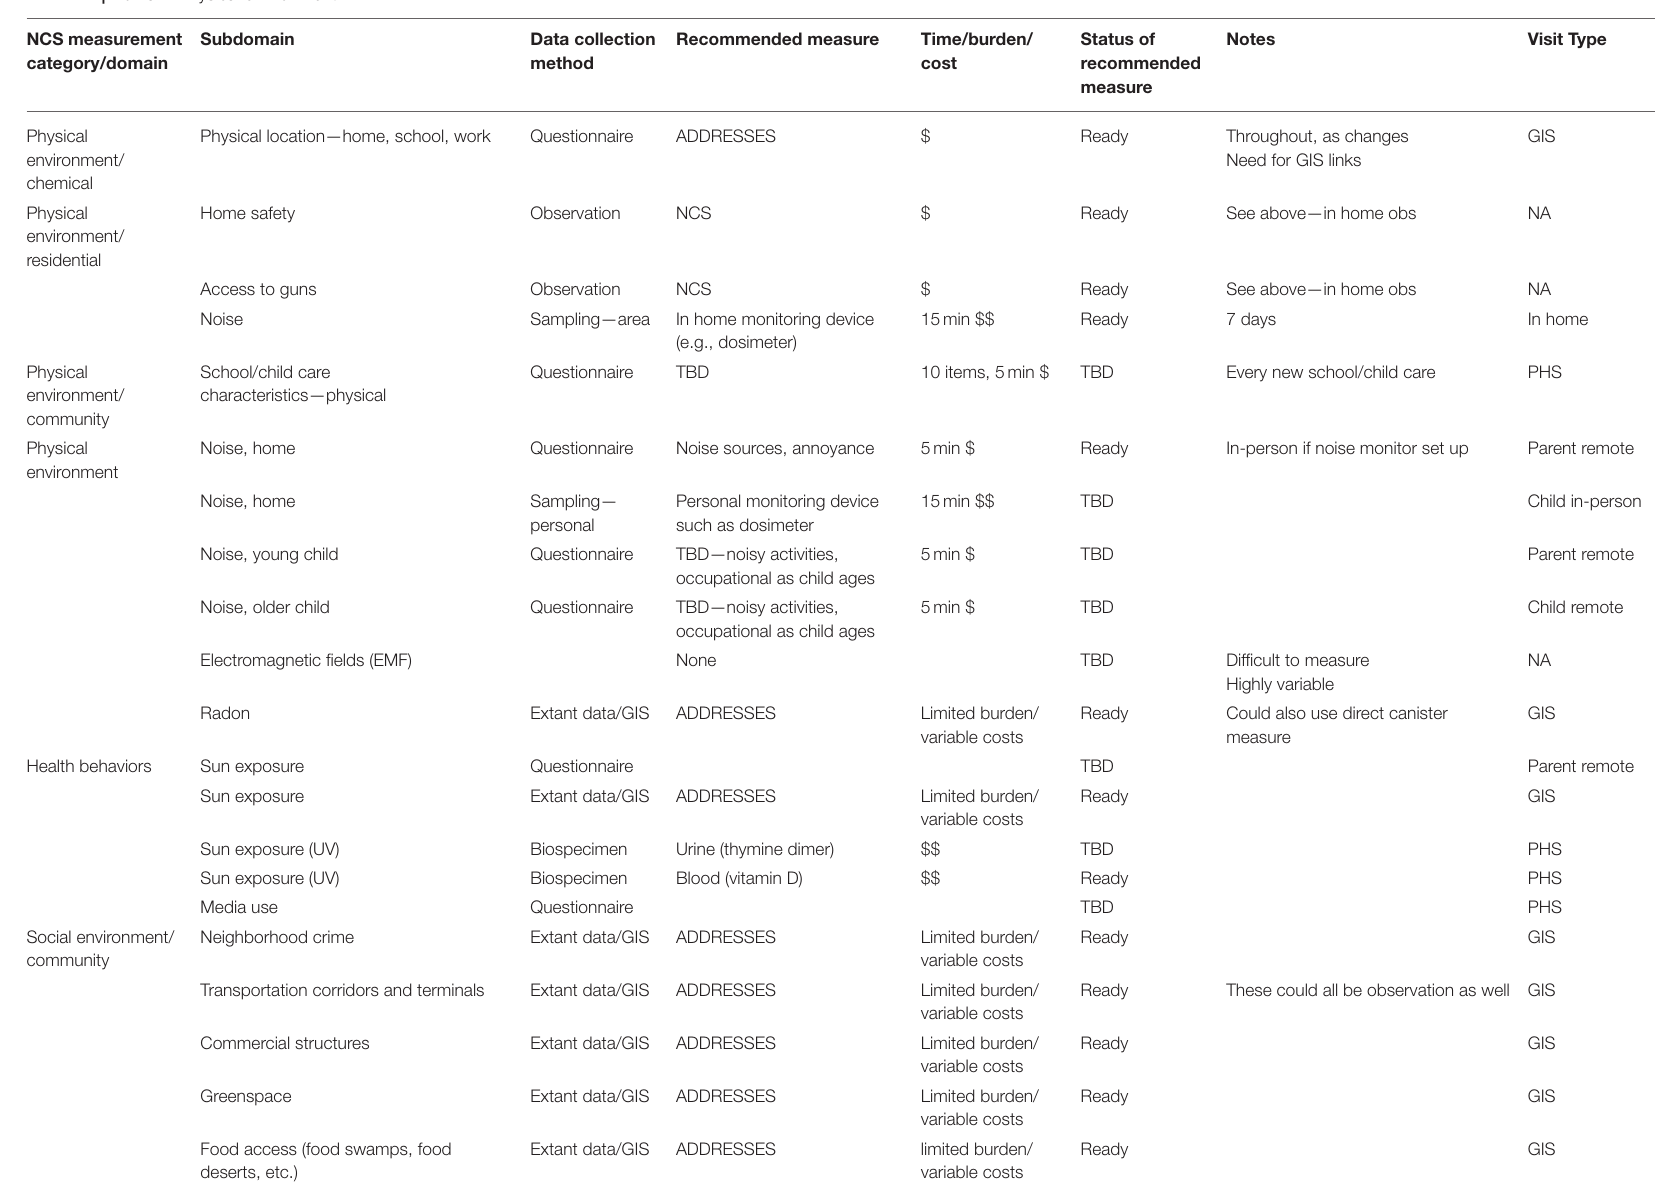
TABLE 2 | Domain: Physical environment. NCS measurement